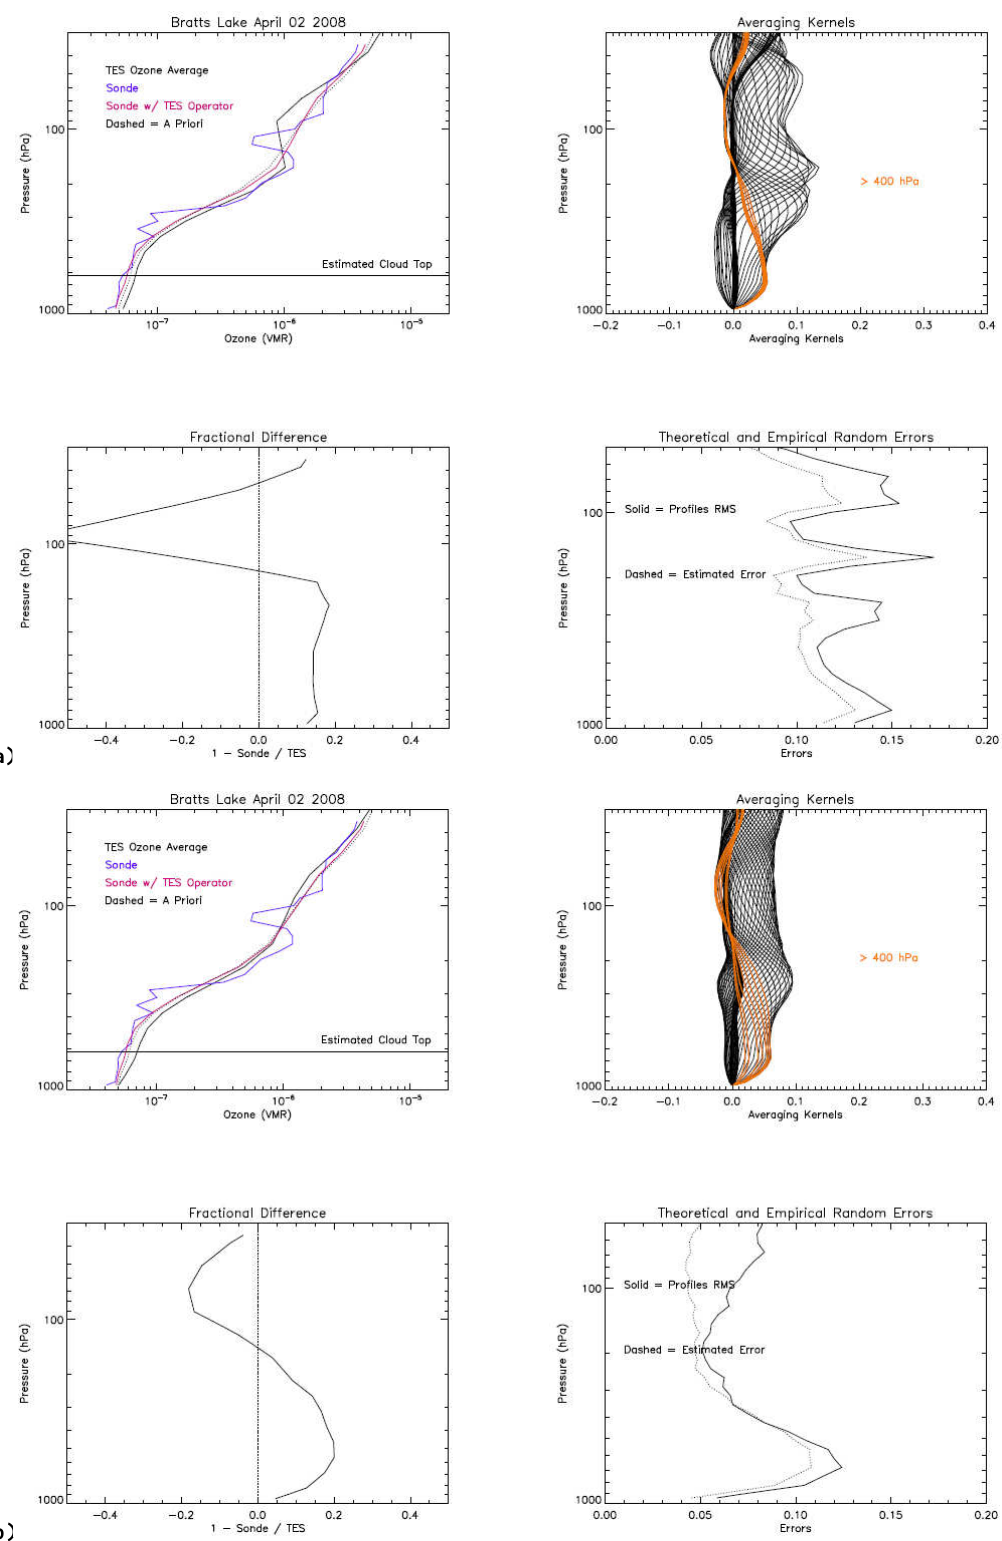
Fig. 1. The TES-stare sequence on 2 April 2008 over Bratt’s Lake started at 20:04 (UTC), and the ozonesonde on that day at Bratt’s Lake was launched at 20:01 (UTC), using V003 (a) and V004 (b) TES